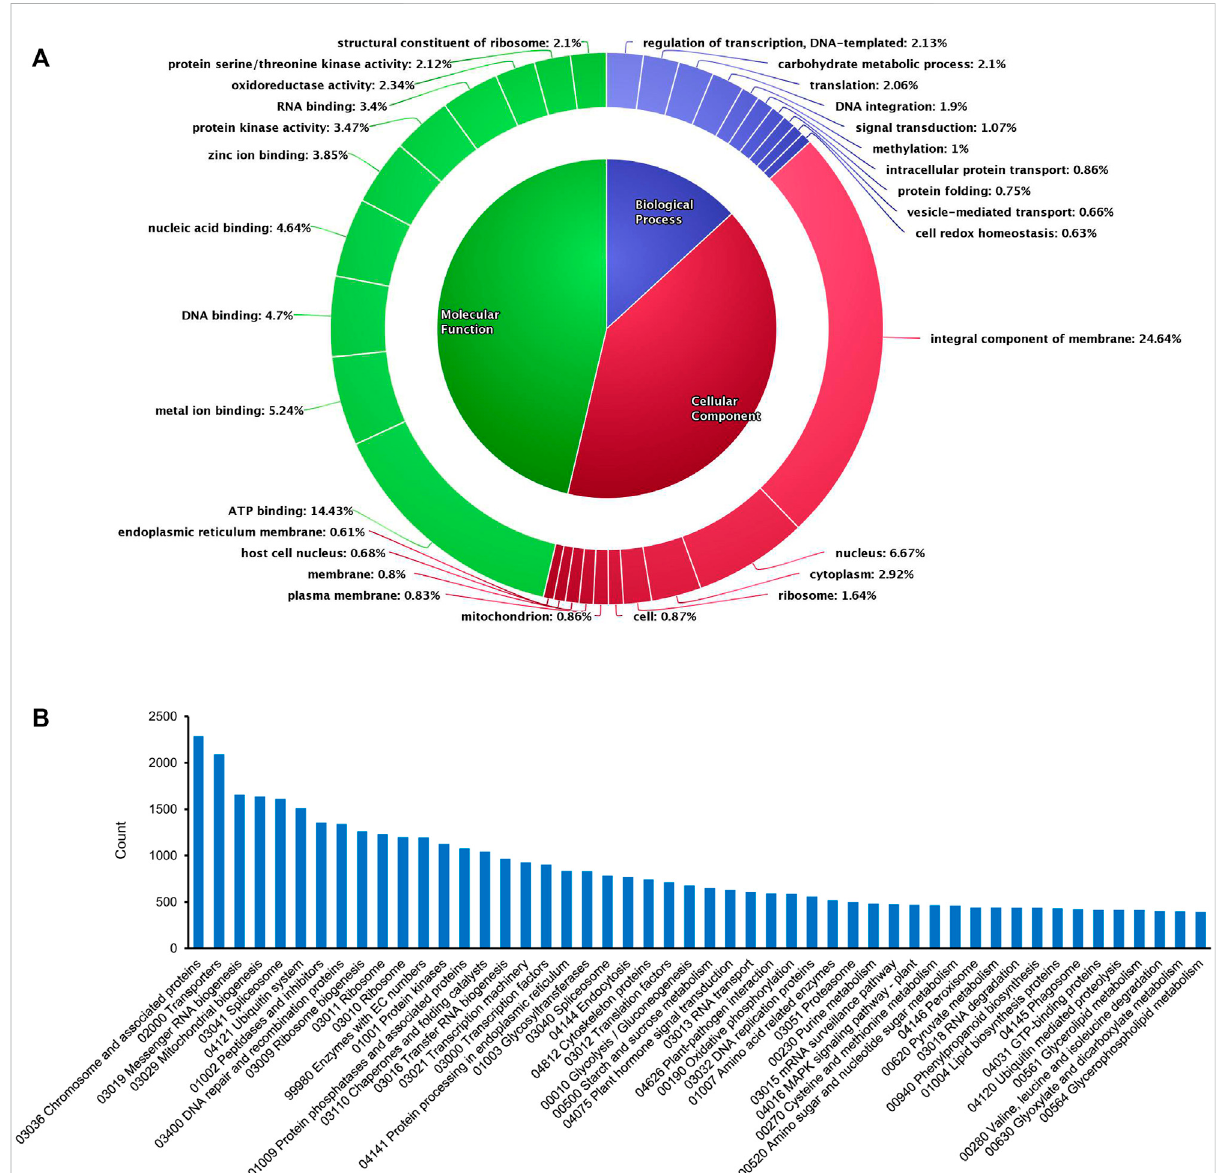
FIGURE 1 OverviewofGOandKEGGenrichmentanalysisofthedenovoassembledtranscriptsinthepresentstudy. (A) GeneOntologychartshowingthe distribution of various transcripts. (B) Top 50 pathways observed in KEGG pathway